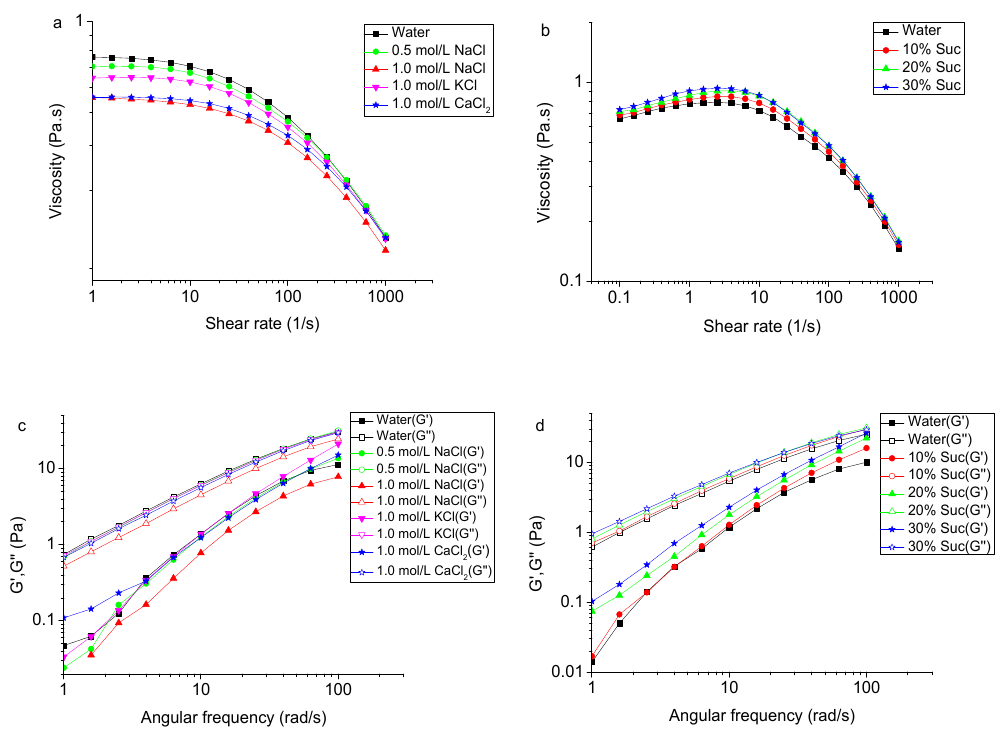
Figure 7. ( a ) Effect of Na + , K + , Ca 2+ on the apparent viscosity of TSP (2%, w / v ) at 25 °C; ( b ) Effect of sucrose on the apparent viscosity of TSP (2%, w / v ) at 25 °C; ( c ) Effect of Na + , K + , Ca 2+ on dynamic modulus of TSP (2%, w / v ) at 25 °C; ( d ) Effect of sucrose on dynamic modulus of TSP (2%, w / v ) at 25 °C.